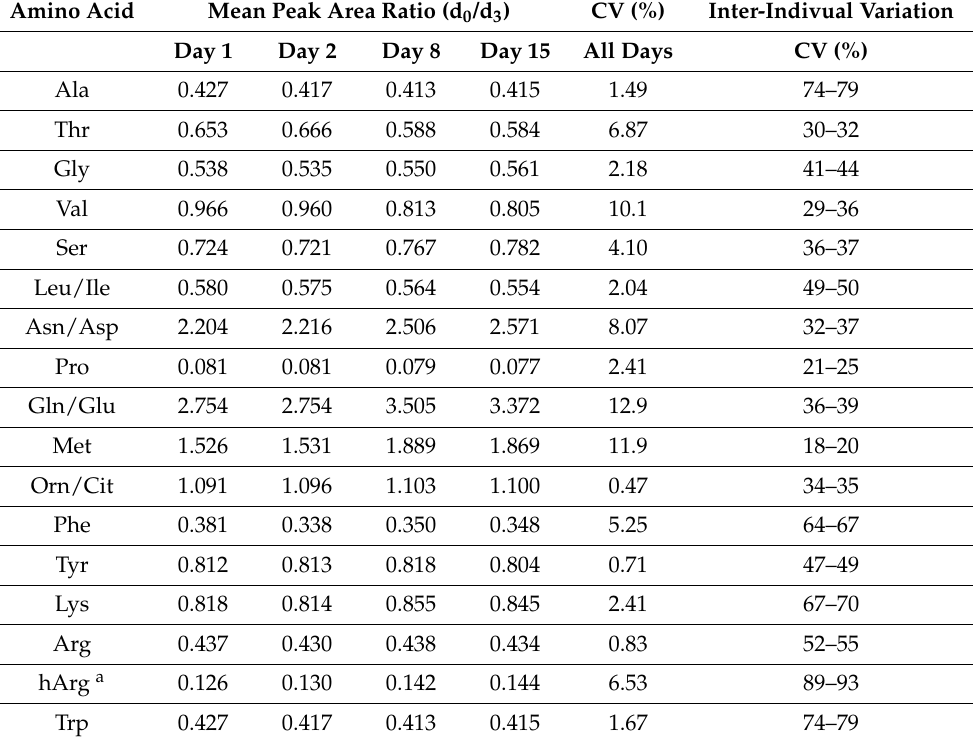
Table 2. Mean peak area ratio and its coefficient of variation (CV) of the indicated endogenous amino acids (d 0 ) in urine samples from seven volunteers to the respective internal standards (d 3 ) as measured by GC–MS analysis of 1 µ L aliquots of the toluene extracts stored at room temperature for several days. Amino